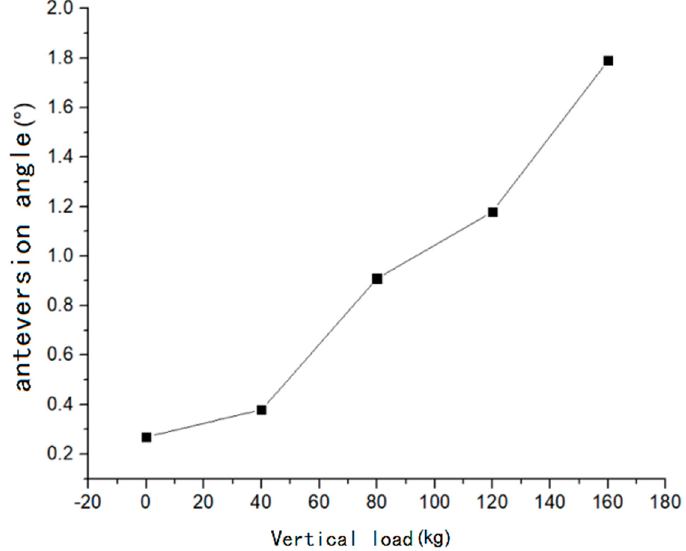
Figure 21. Relationship between forward tilt angle and vertical load.